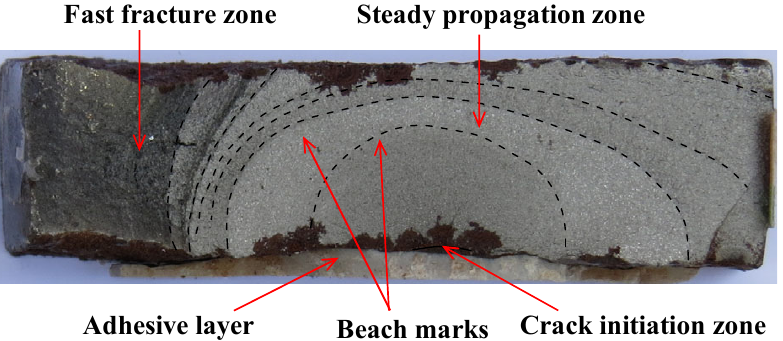
Figure 3. Typical fracture surface of the corroded steel plate strengthened with CFRP plates (specimen C9-DS1-A in [14,37]). Table 2. Results summary of the fatigue test and fatigue crack propagation prediction.